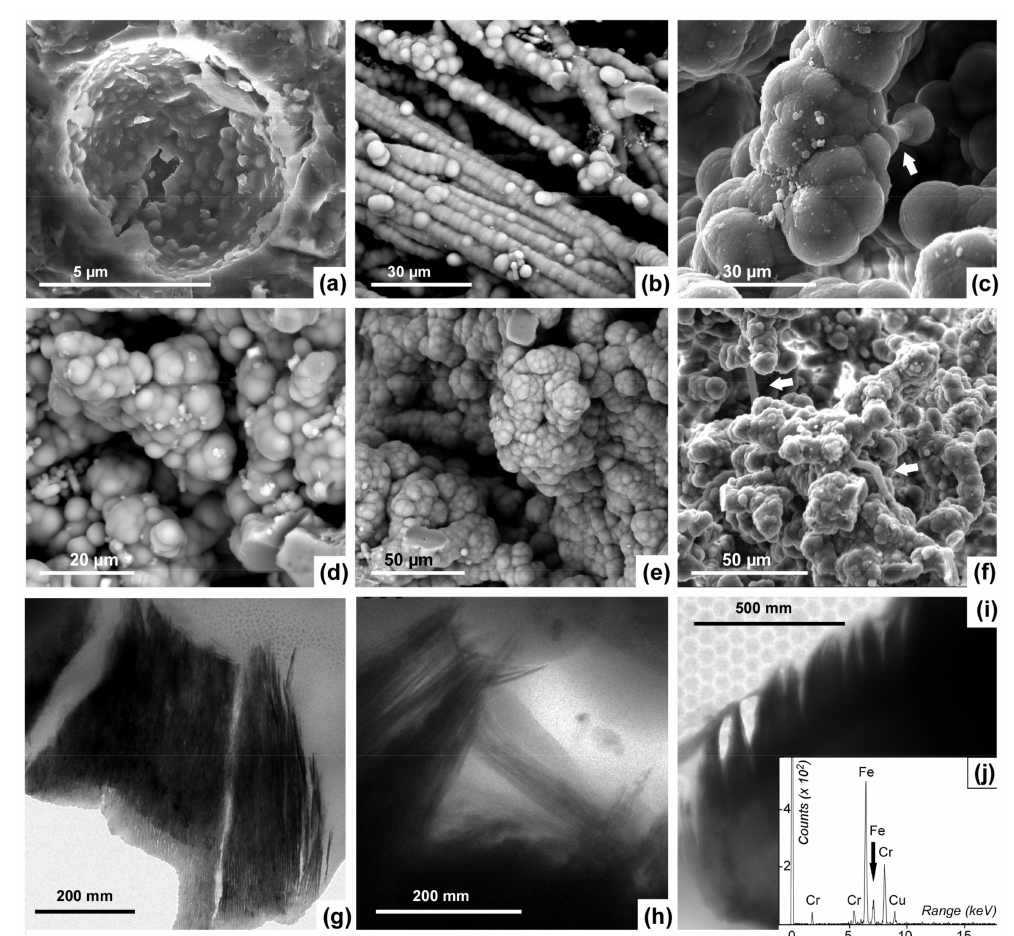
Figure 9. SEM images from samples of the Selt ú n sinter showing coalescing opal-A spheres and the subsequent disappear- ance of microbial distinctiveness. ( a ) Broken opal-A sphere showing an internal hollow formed by a crust of smaller spheres, less than 350 nm in diameter. ( b ) Entangled filaments punctuated by opal spheres blurring their microbial distinctiveness. ( c – e ) Botryoidal clusters of opal-A spheres overgrowing microbial filaments; see the neck connecting a mammillated filament with an isolated opal sphere (arrowed). ( f ) Botryoidal mass of opal-A precluding identification of any original microbial remain, except two well-preserved filaments (arrowed) postdating the growth of the botryoidal mass. ( g – i ) High resolution transmission electron microscopy (HRTEM) micrographs of laths and slightly curved needles of goethite (EDX analysis) growing transversally to ellipsoidal outlines of opal-A agglomerates. These mineral associations mimic bacteriomorphs wrapped with iron-rich acicular nanoprecipitates. ( j ) EDS spectra of these iron biominerals embedded in fine exopolymeric substances (EPS) films; Cu and Cr signals are from the supporting